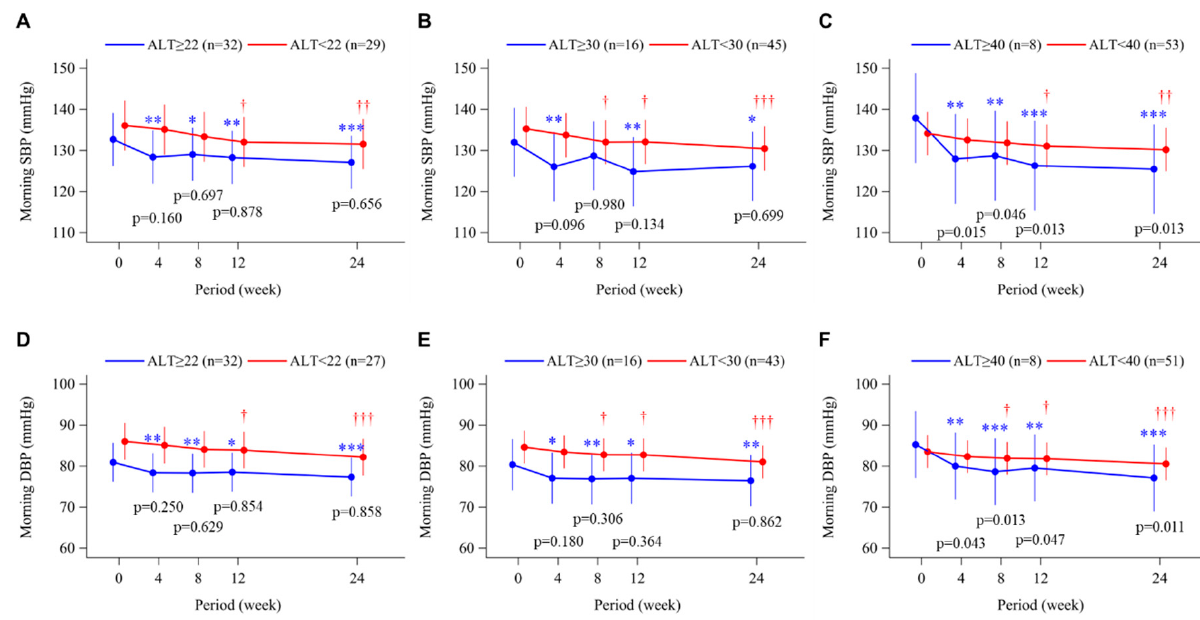
Figure 2. Time course of changes in morning home systolic blood pressure (SBP; A – C ) and diastolic blood pressure (DBP; D – F ) from baseline to week 24 in the topiroxostat-treated group. Patients were divided into groups according to baseline alanine aminotransferase (ALT) level, above or below 22 U/L (median value; A , D ), 30 U/L ( B , E ), and 40 U/L (upper limit of normal; C , F ). Points and bars represent the least-squares mean and 95% confidence interval values using a mixed-effects model with repeated measures adjusted for sex and age. p-values within each graph are for the between-group difference in change from baseline. * p < 0.05, ** p < 0.01 and *** p < 0.001 for change from baseline in the ALT-high group. † p < 0.05, †† p < 0.01 and ††† p < 0.001 for change from baseline in the ALT-low group.